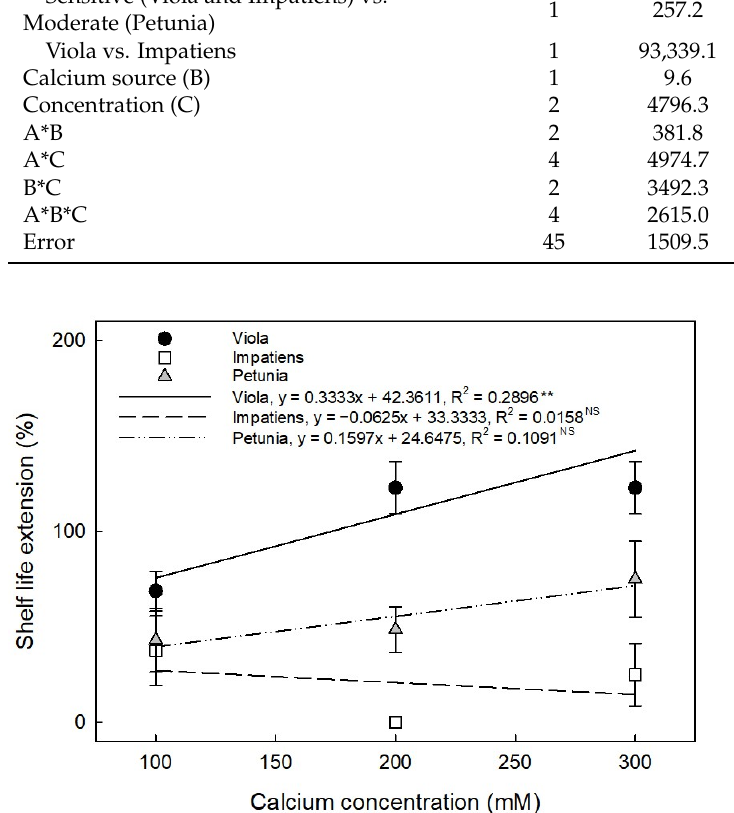
Figure 3. Influence of calcium concentration on shelf life extension of V. cornuta (viola), I. walleriana (impatiens), and P. grandiflora (petunia) in drench application. Each data point represents the mean of shelf life extension from CaCl 2 and Ca(NO 3 ) 2 , but the analysis was performed with all data (n = 8 for viola and impatiens and n = 6 for petunia). Bars represent standard error. NS, nonsignificant; **, significant at P ≤ 0.01.